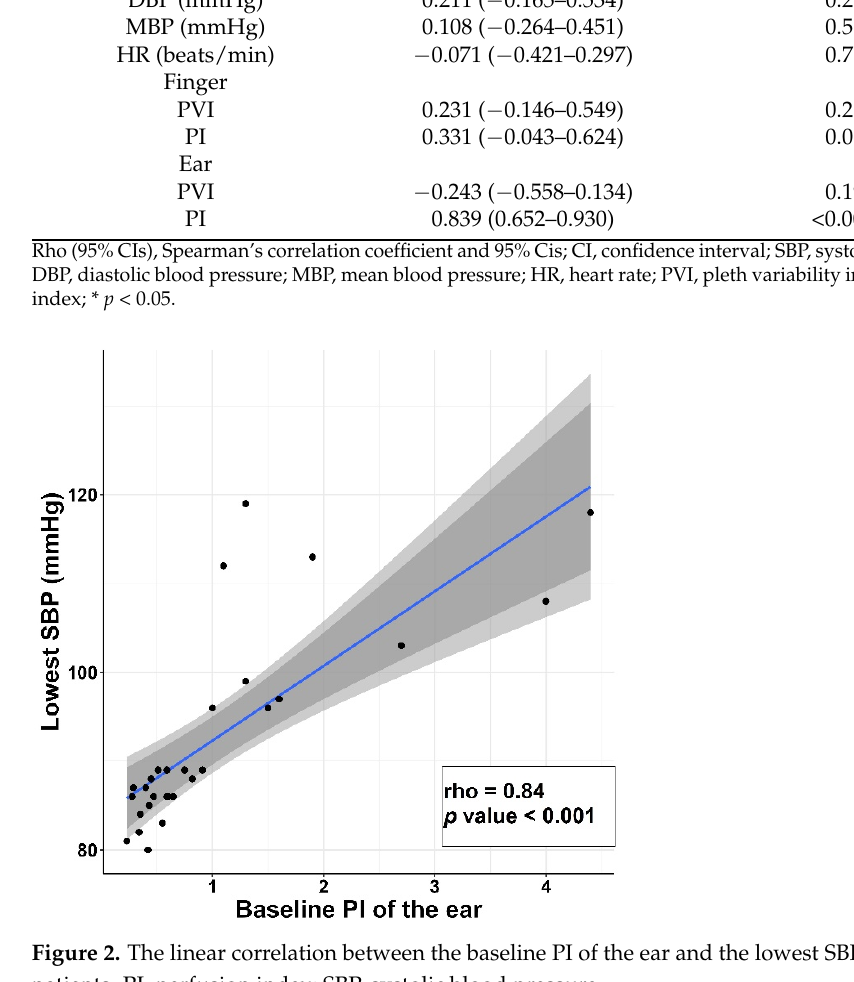
Figure 2. The linear correlation between the baseline PI of the ear and the lowest SBP (mmHg) of the patients. PI, perfusion index; SBP, systolic blood pressure. Table 2. Comparison of baseline hemodynamic data between patients with and without hypoten- sion after the induction of anesthesia.